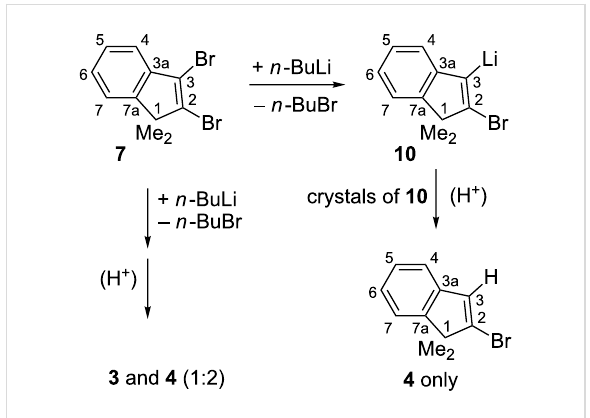
Scheme 3: Unsolvated 2-bromo-3-lithio-1,1-dimethylindene ( 10 ) pre- cipitated from the reaction mixture of 7 with n -BuLi in hexane; after purification, 10 provided 4 only; Me =